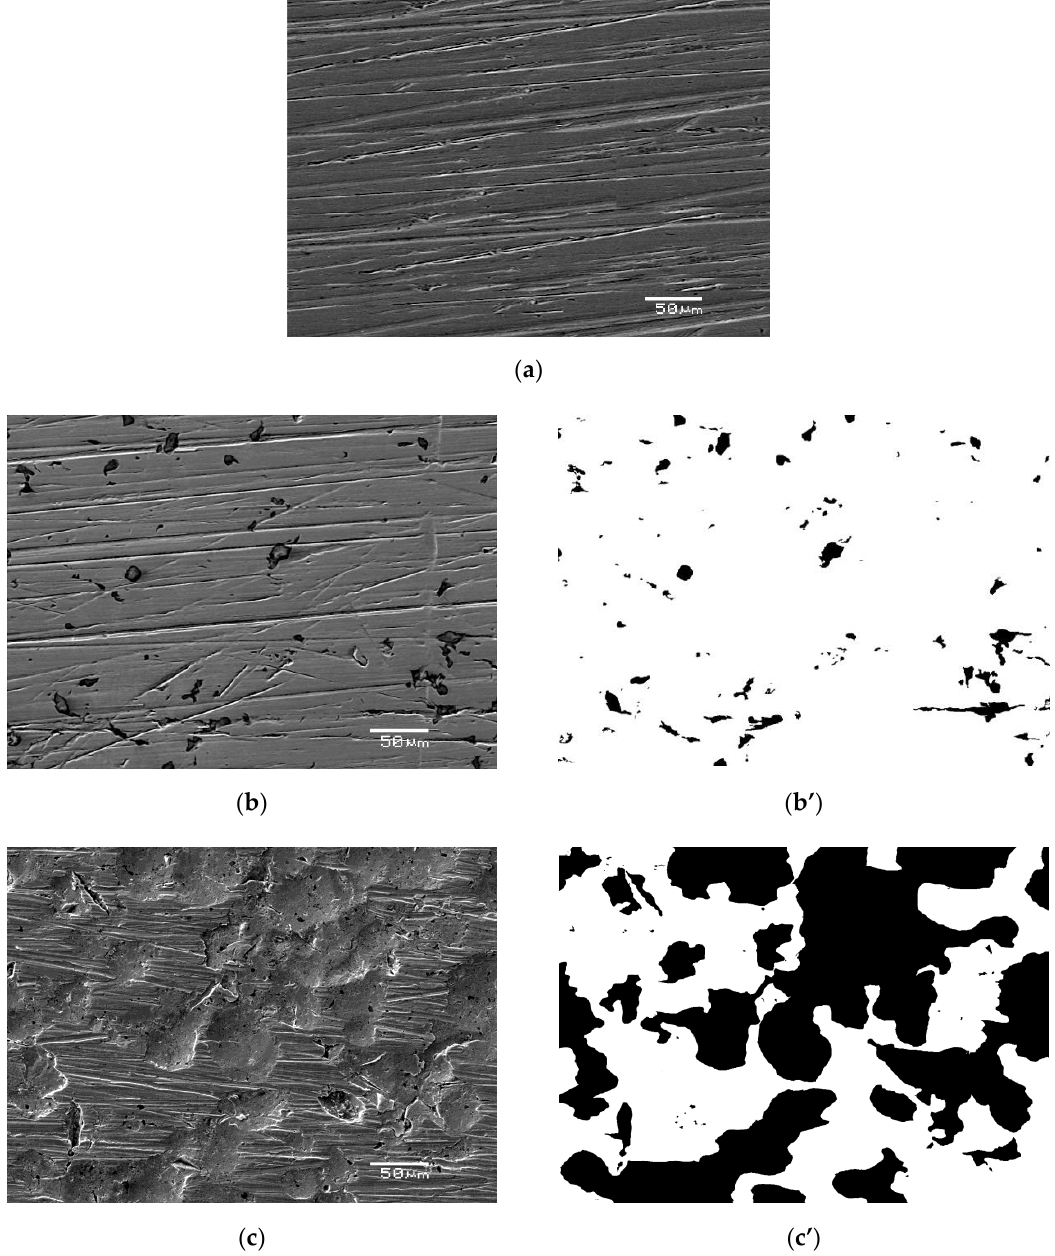
Figure 4. Exemplary scanning electron microscope (SEM) images for the AISI 1010 steel electrode in initial state ( a ) and immersed in sulfolane at 95 ◦ C [25] ( b ) and 230 ◦ C ( c ) as well as corresponding black and white images ( b’ , c’